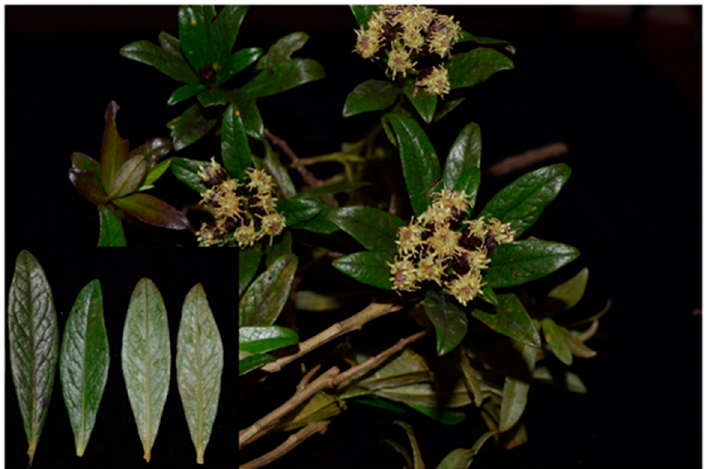
Figure 1. The branches of Baccharis macrantha with the flowering, the leaves with a shiny surface, and the underside with creamy-white wax (lower left side). the underside with creamy-white wax (lower left